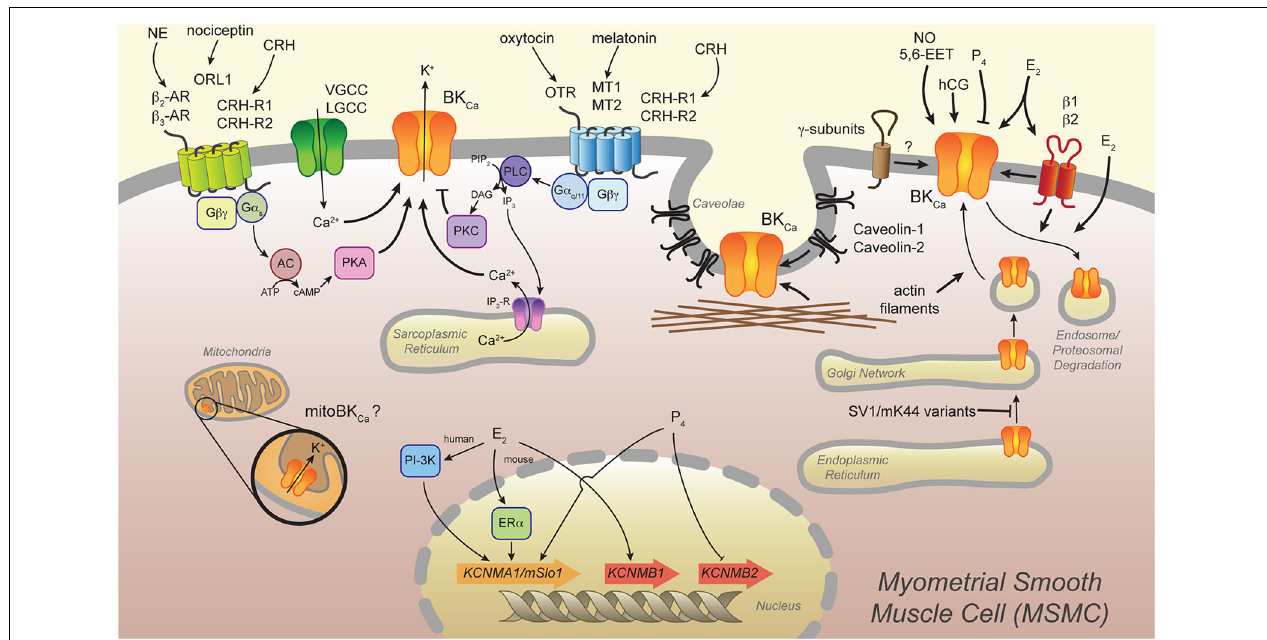
FIGURE 1 | Several mechanisms modulate the BK Ca channel in the myometrium. Certain splice variants (SV1 and mK44) of the BK Ca channel are retained in the endoplasmic reticulum, whereas actin filaments induce traffic of BK Ca to the plasma membrane of the myometrial smooth muscle cell (MSMC). Localization of BK Ca channels in membrane microdomains (i.e., caveolae) and interaction with caveolin-1 and -2 and actin filaments modulate the channel’s activity. The BK Ca auxiliary β 1- and β 2-subunits modify channel activation by direct interaction and, in the case of β 1, by inducing its internalization to endosomes. Novel BK Ca auxiliary γ -subunits are expressed in the uterus, but their significance for MSMC excitability has not been assessed. The vasoactive molecules nitric oxide (NO) and epoxyeicosatrienoic acid (5,6-EET) induce relaxation of the myometrium likely by modulation of BK Ca channel activity. The steroid hormones 17 β -estradiol (E 2 ) and progesterone (P 4 ) are important in maintaining pregnancy and inducing labor. These hormones modulate activity of the BK Ca channel in several ways: directly modulating BK Ca channel activity, inducing proteosomal degradation of the channel, and regulating expression of the genes encoding the BK Ca α -subunit ( KCNMA1 / mSlo1 ) or β -subunits ( KCNMB1 and KCNMB2 ). Another pregnancy-related hormone, human chorionic gonadotropin (hCG), modulates BK Ca channel activity to induce relaxation of the myometrium.